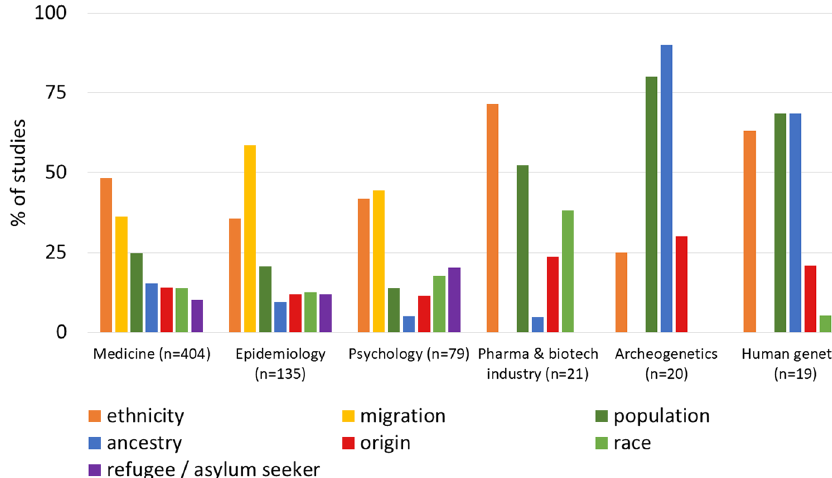
Fig. 4 Frequency of classifi- cation terms used in differ- ent research areas. Many of the studies analyzed were assigned to several disci- plines, thus there is an overlap between research